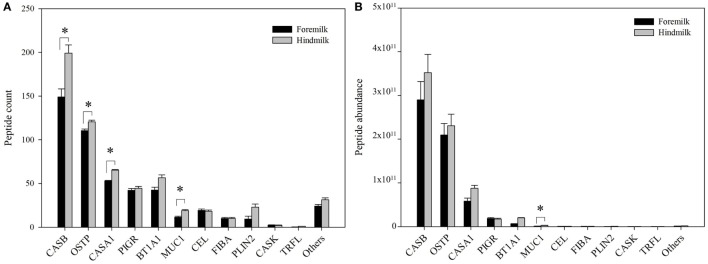
Count (A) and abundance (B) of peptides derived from either foremilk or hindmilk. Results are shown as least square means ± SE, n = 4. Asterisks (*) indicate significant differences between foremilk and hindmilk (P < 0.05). CASB, β-casein; OSTP, osteopontin; CASA1, αs1-casein; BT1A1, butyrophilin subfamily 1 member A1; PIGR, polymeric immunoglobulin receptor; CEL, bile salt-activated lipase; PLIN2, perilipin-2; MUC1, mucin-1; FIBA, fibrinogen α-chain; CASK, κ-casein; TRFL, lactoferrin.